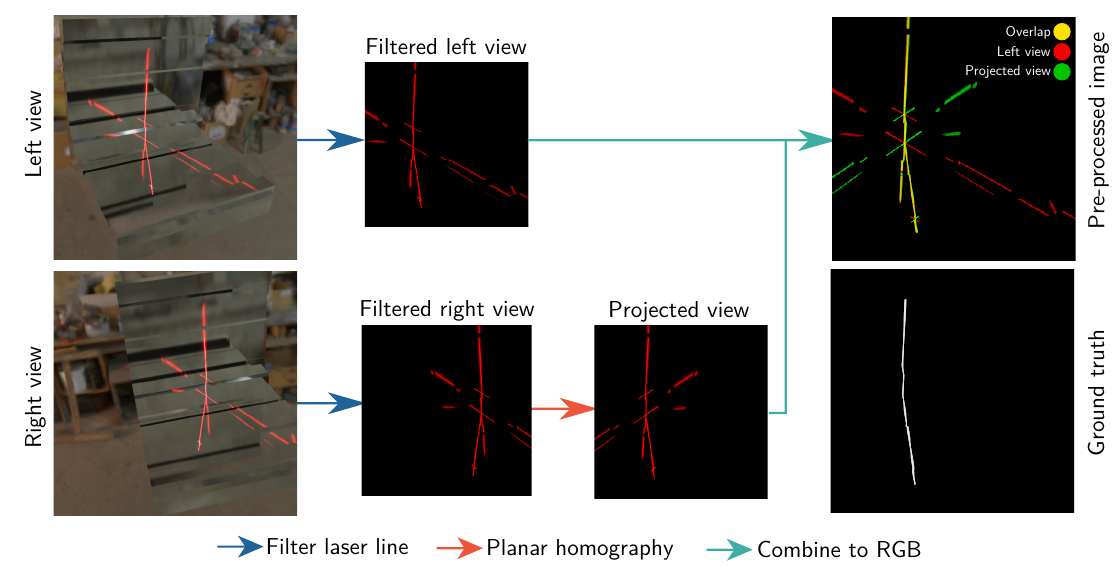
Figure 10: The planar homography preprocessing requires a filtered view of the laser from two cameras. One of the filtered views is then projected using a planar homography, such that when the two views are combined, the true laser line will overlap while many spurious reflections will not.